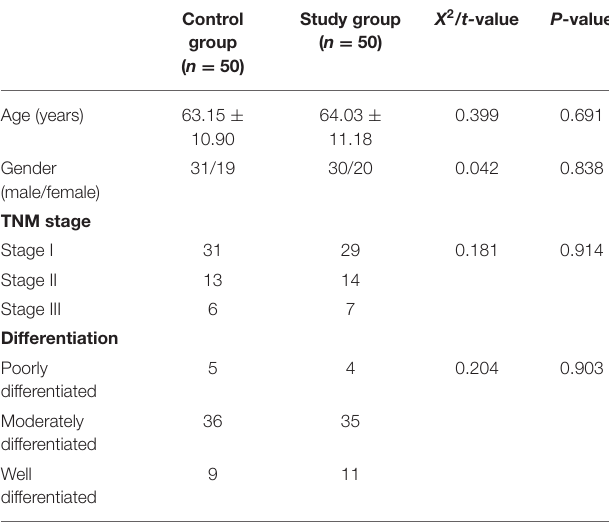
TABLE 1 | The baseline data of the two